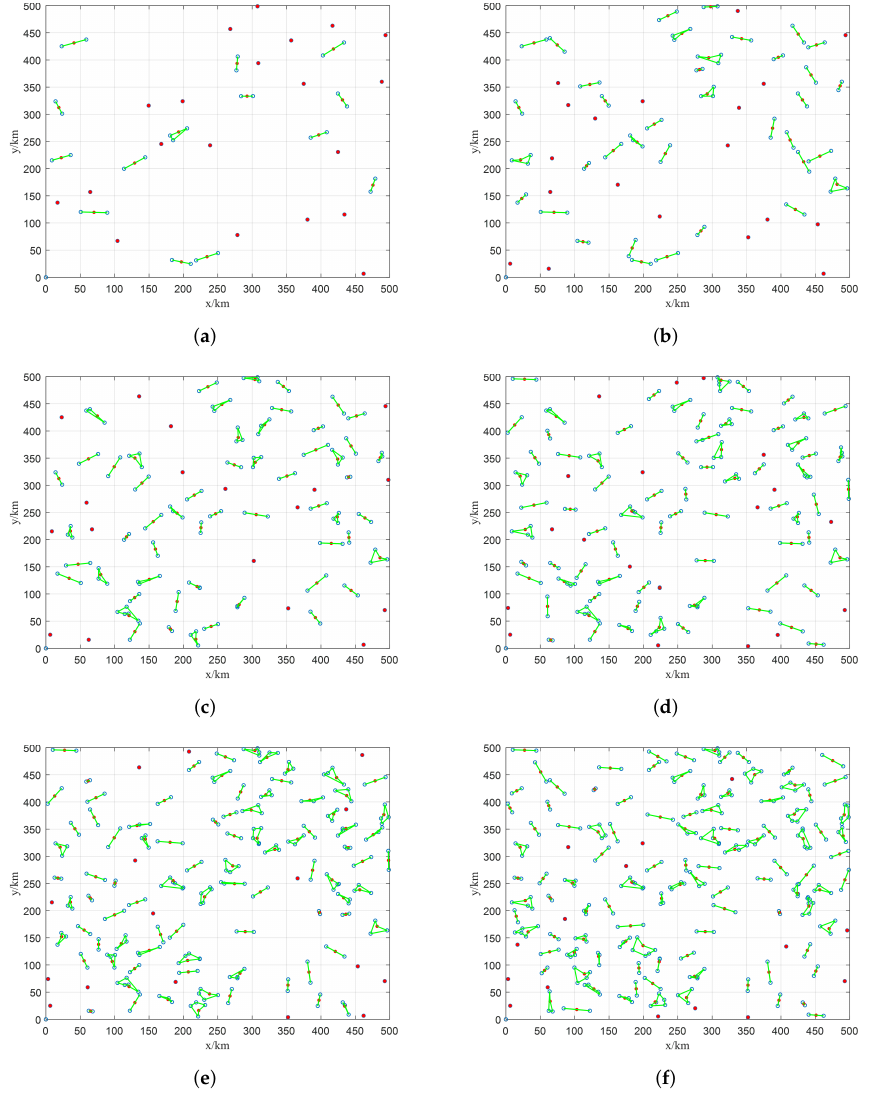
Figure 8. Scheduling results of HASS with different numbers of targets. ( a ) 50 targets, ( b ) 100 targets, ( c ) 150 targets, ( d ) 200 targets, ( e ) 250 targets, ( f ) 300